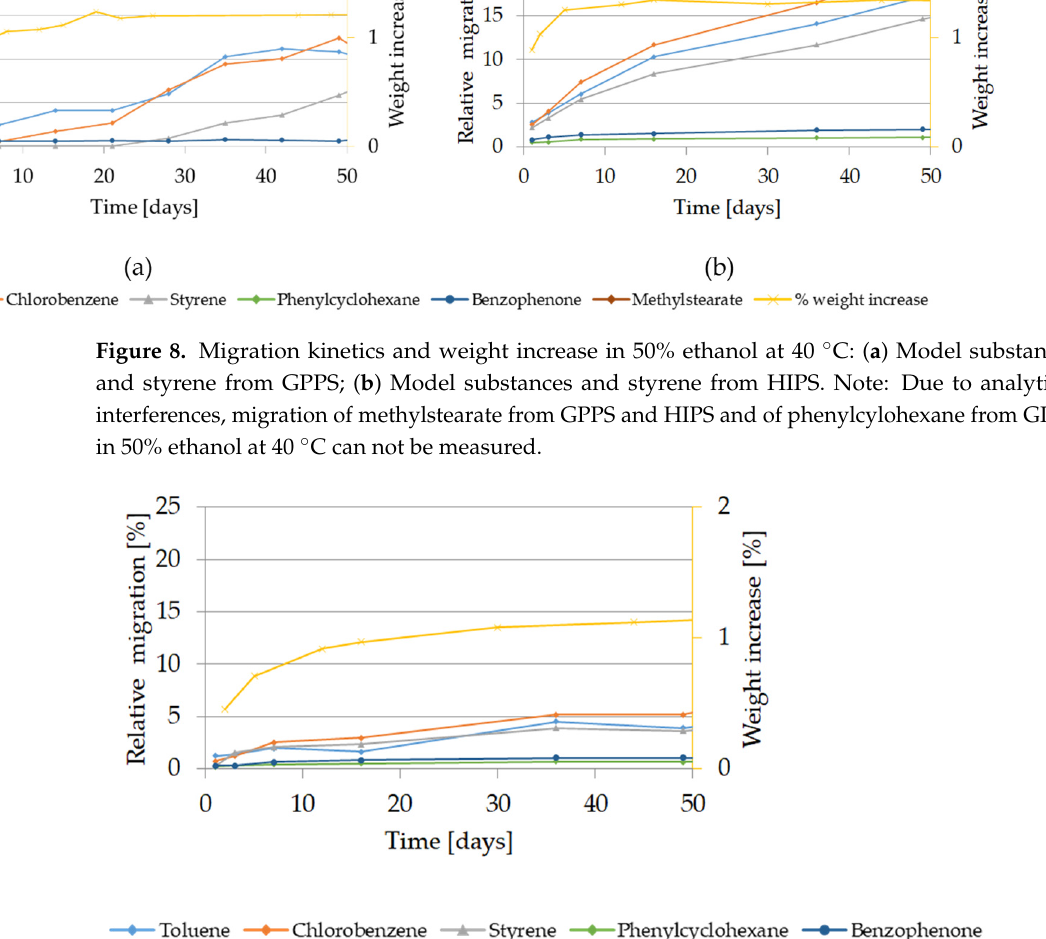
Figure 9. Migration kinetics and weight increase in 50% ethanol at 20 ◦ C from HIPS. Note: Due to analytical interferences, migration of methyl stearate from HIPS in 50% ethanol at 20 ◦ C can not be measured.